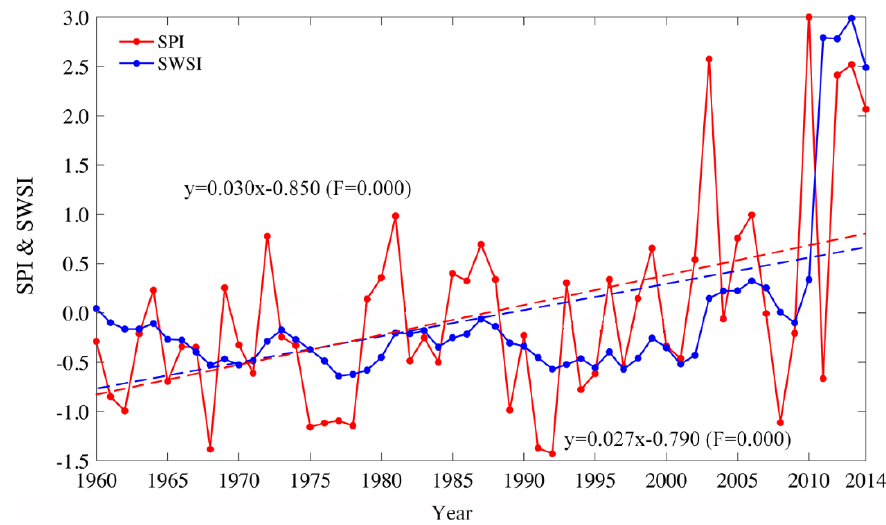
Figure 3. The variations of annual SPI and annual SWSI during the period of 1960 to 2014.